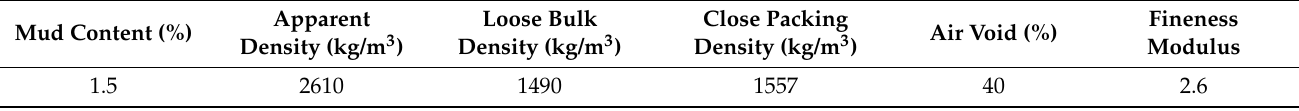
Table 2. The physical properties of fine aggregates used in this